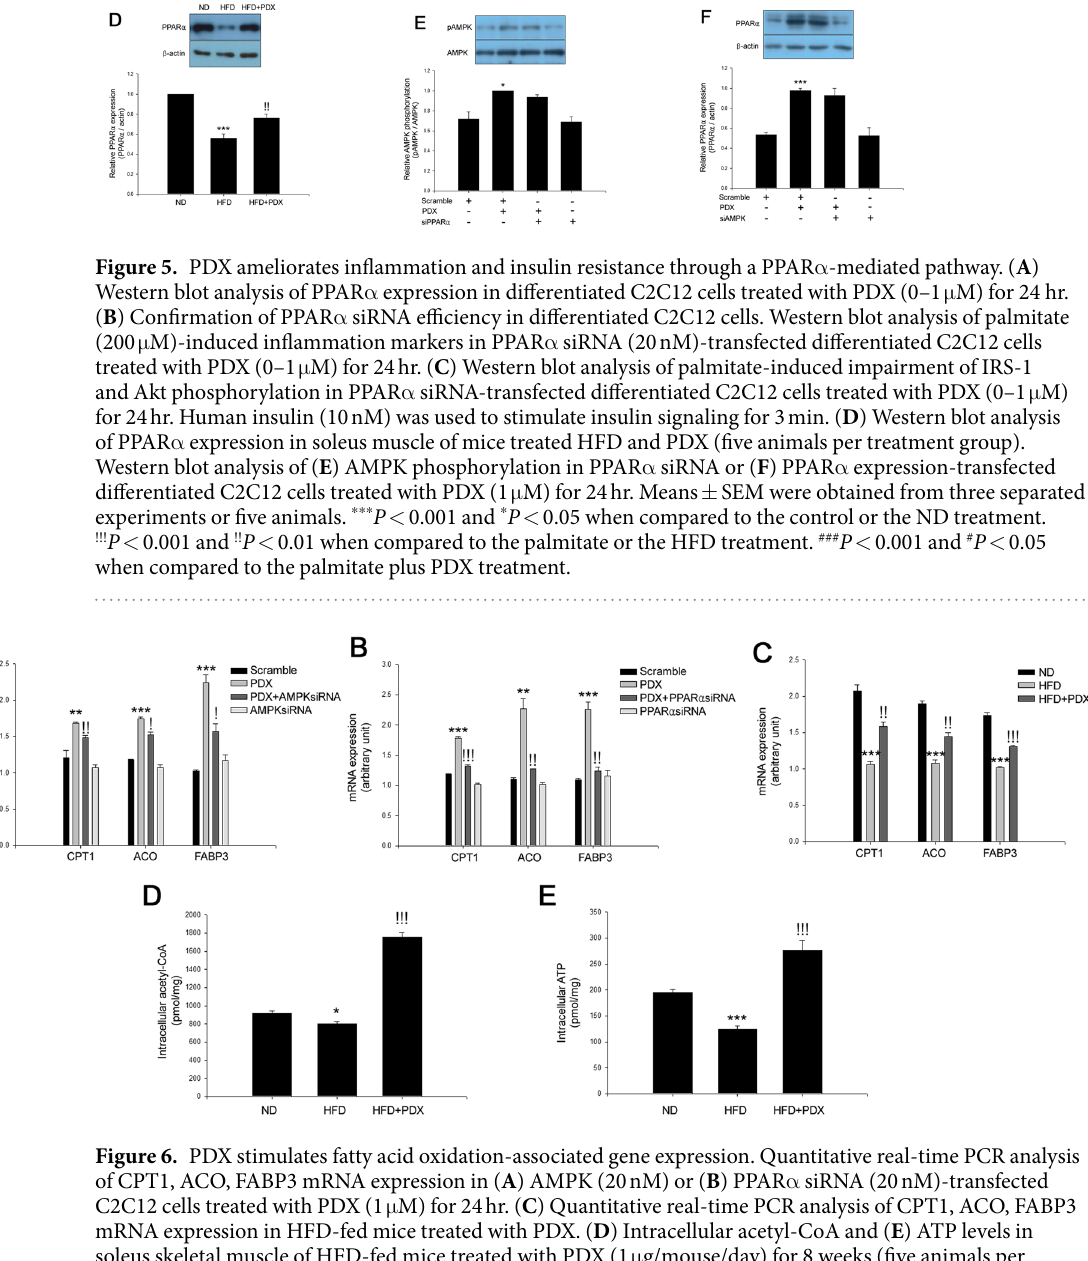
IL-6 expression than the HFD group, showing that the higher serum IL-6 concentration in PDX-treated mice may be mainly derived from skeletal muscle (Supplemental Figure S2C and